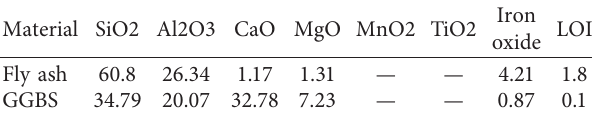
Table 2: Chemical analysis of fly ash and GGBS (in weight